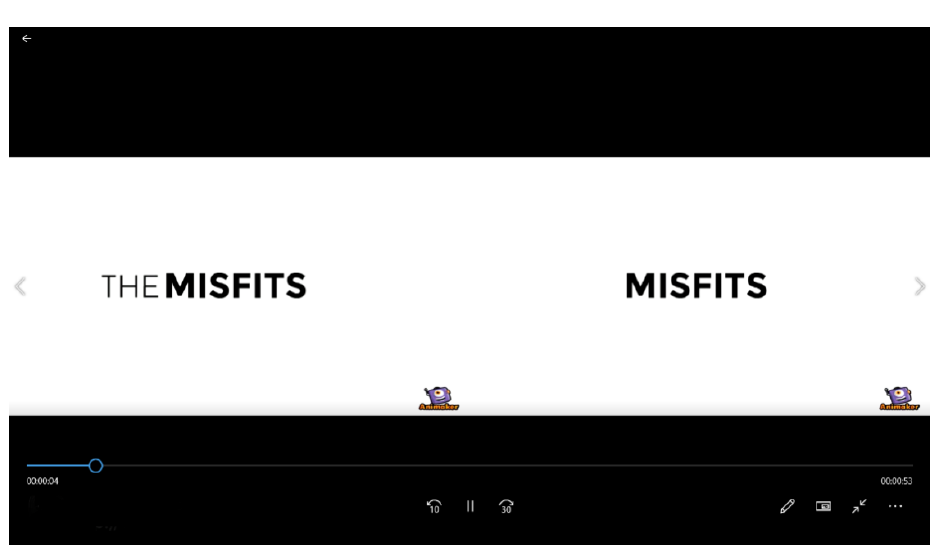
Figure 1. A frame of text video without a background and with a left-to-right arrangement.